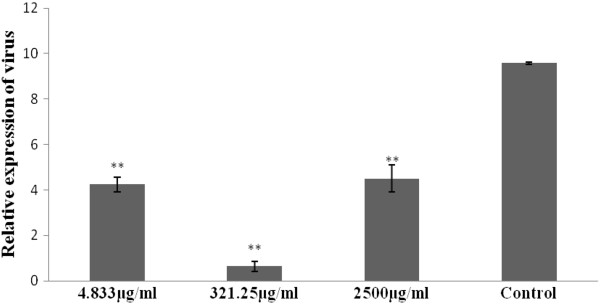
Illustrates the relative expression of H9N2 virus in CEF at various APS concentrations for the pre-addition APS group. The inhibition efficiency of APS was more significant at 321.23μg/mL than for 2,500 and 4.833μg/mL.